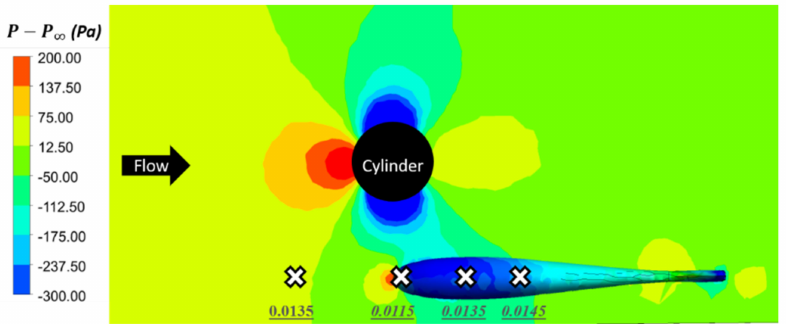
Figure 9. Variation of C D _ Mean with the position (relative to obstruction) for nonoscillatory